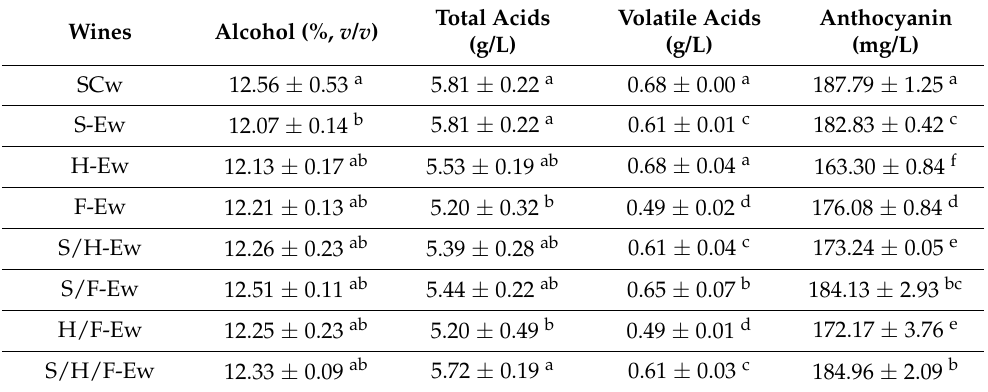
Table 2. Physicochemical characteristics of